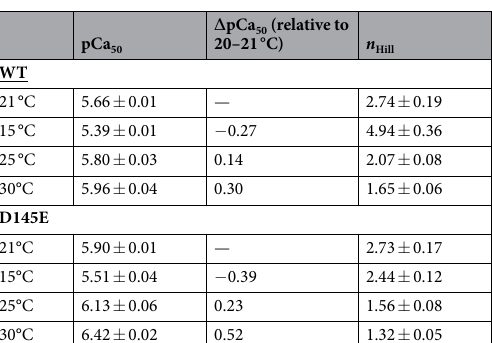
1.32 ± 0.05 Table 2. Apparent affinity for Ca 2 + increases more with temperature in cardiac skinned fibres reconstituted with HcTnC D145E. The Ca 2 + sensitivity of isometric force was measured at 15°, 25° and 30° on each fibre, after extraction of endogenous cTnC and reconstitution with recombinant HcTnC, as described in Methods. pCa 50 and n Hill are from the experiments of Fig. 7a–c (n = 4–5) or (at 20–21 °C) from Landstrom et al . 8 (n = 8). Data reported at 20–21 °C were not tested against the others. Errors are ± s.e.m. For each protein, pCa 50 values at 15 °C, 25 °C and 30 °C are significantly different from each other (p ≤ 0.022). Paired t -test was used. pCa 50 values at the same temperature (15 °C, 25 °C or 30 °C) are significantly different for the two proteins (p ≤ 0.01). Unpaired t -test was used. In the last column, n Hill values for D145E are significantly different from WT (p ≤ 0.005) at the same temperature (15 °C, 25 °C or 30 °C). Unpaired t -test was used. In the last column, n Hill values within each group (WT or D145E) are statistically different from each other (p ≤ 0.028). Paired t -test was